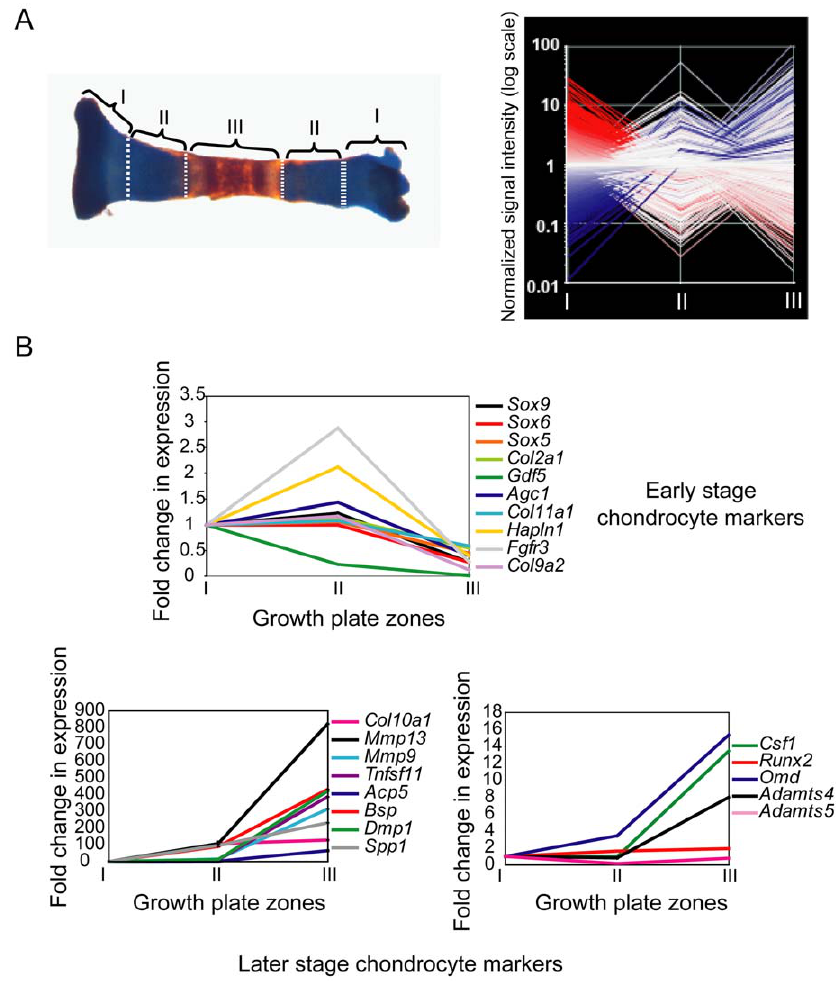
Figure 1. Tibia microdissection and microarray analysis of microdissected zones. Tibiae from 15.5 day old mouse embryos were dissected into three segments called zones I, II and III. Striated lines indicate location of manual segmentation (A, left panel). Growth plate segments for each zone were pooled and total RNA was isolated and hybridized to Affymetrix MOE 430 2.0 chips containing 45 101 probe sets. This experiment was repeated in quadruplicate (A, right panel). Red lines denote probe sets with increased expression in zone I relative to the baseline signal intensity and blue lines denote probe sets that are decreased relative to the baseline signal intensity. White lines represent genes expressed near the baseline intensity. Growth plate microdissection reveals expected expression profiles for established markers of endochondral bone formation. (B) Microarray expression profiles for chondrocyte differentiation sox family members 5, 6 and 9, ( Sox- 5, 6 and 9 ), collagen 2 ( Col2a1 ), growth differentiation factor 5 ( Gdf5 ), aggrecan 1 ( Agc 1 ), collagen XI alpha 1 ( Col11a1 ), hyaluronan and proteoglycan link protein 1 or cartilage link protein 1( Hapln1 ), fibroblast growth factor receptor 3 ( Fgfr3 ) and collagen IX alpha 2 ( col9a2 ) are shown (top panel). Late-stage markers of endochondral ossification exhibiting large increases in gene expression in zone III include collagen X ( Col10a1 ), matrix metalloproteinase 13 ( Mmp13 ), matrix -metalloproteinase 9 ( Mmp9 ), tumor necrosis factor (ligand) superfamily, member 11 or receptor activator of NF-kappaB ligand ( Tnfsf11 ), acid phosphatase 5, tartrate resistant ( Acp5 ), integrin binding sialoprotein ( Ibsp ), dentin matrix protein ( Dmp1 ) and osteopontin ( Spp1 ) (bottom left panel). Expression profiles for later stage markers that exhibit more moderate increases in zone III included colony stimulating factor 1 ( Csf1 ), runt related transcription factor 2 ( Runx2 ), osteomodulin ( Omd ), a disintegrin- like and metallopeptidase (reprolysin type) with thrombospondin type 1 motif, 4 and 5 ( Adamts4, Adamts5 ) (panel, right